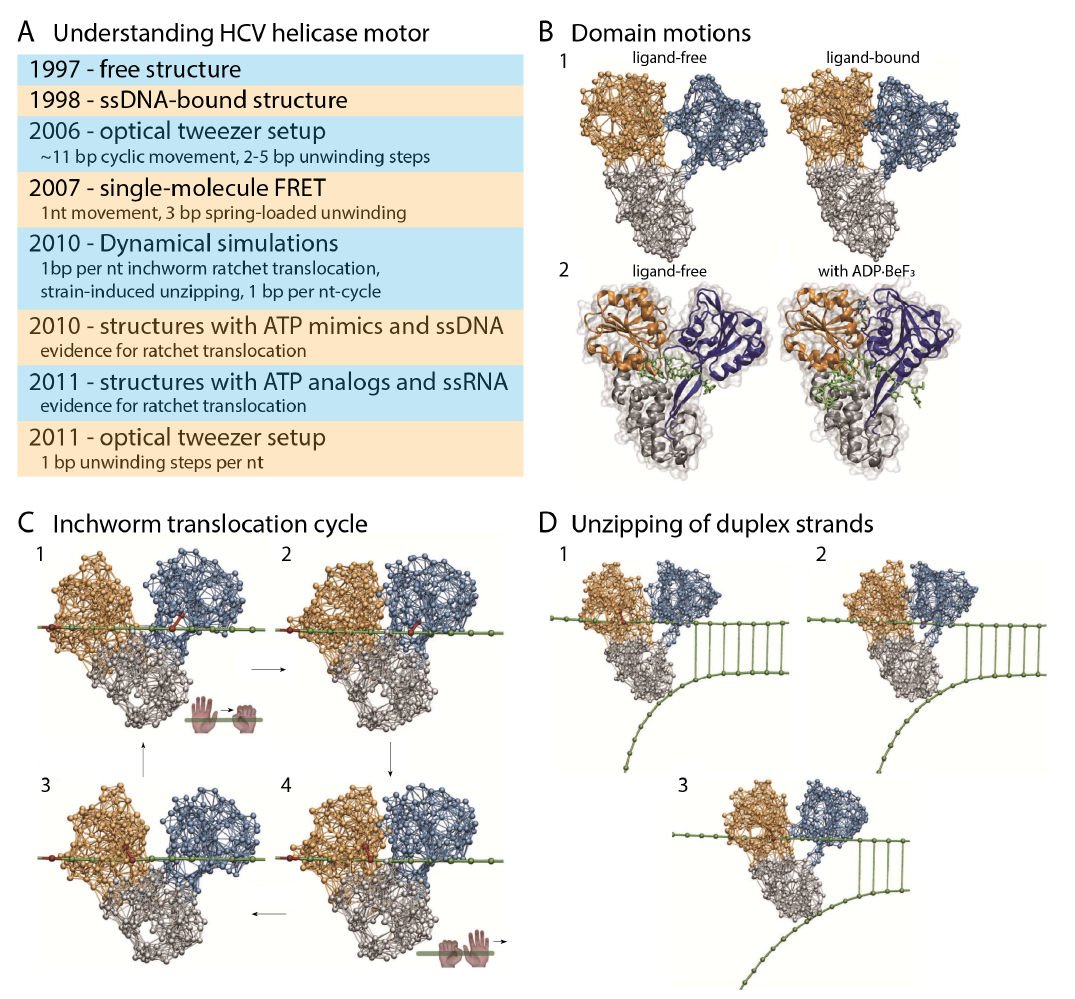
Figure 4. Entire operation cycles from ENM. ( A ) Table showing the main experimental efforts and observed/proposed mechanisms for the operation of the hepatitis C virus (HCV) helicase molecular motor. The references for this table are [70,77–83]; ( B – D ) Summary of results of structurally resolved dynamical simulation for HCV helicase based on ENM modeling of this motor; ( B ) Structures obtained from our simulations are compared with crystal structures from [81]; ( C ) Ratcheting inchworm translocation observed in the simulations is shown as snapshots from a single cycle. Employing the alternating hand-on hand-off mechanism of grip control on the nucleic-acid strand, the motor domains can translate their nucleotide-related internal opening and closing motion into their transport by 1 base-pair (bp) per consumed nucleotide; In ( D ), coupling of inchworm translocation to mechanical separation of duplex strands is shown as snapshots